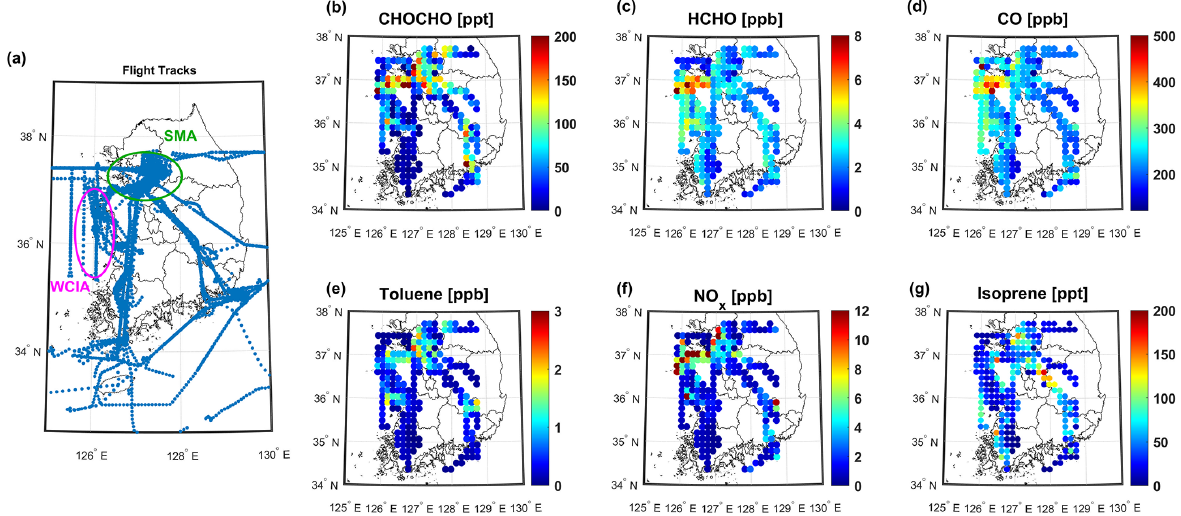
Figure 1. (a) Flight tacks and the geographically averaged (latitude: 0.14 ◦ ; longitude: 0.15 ◦ ) mixing ratios of (b) glyoxal (CHOCHO), (c) formaldehyde (HCHO), (d) carbon monoxide (CO), (e) benzene, (f) toluene, (g) nitrogen oxides (NO x ), and (h) isoprene (below 2km altitude) over Korea measured during the KORUS-AQ campaign. Green and pink circles in (a) represent the Seoul Metropolitan Area (SMA) and West Coastal Industrial Area (WCIA), respectively. The upper limit concentrations were set as the maximum values in each color bar for the visualization of lower-abundance data